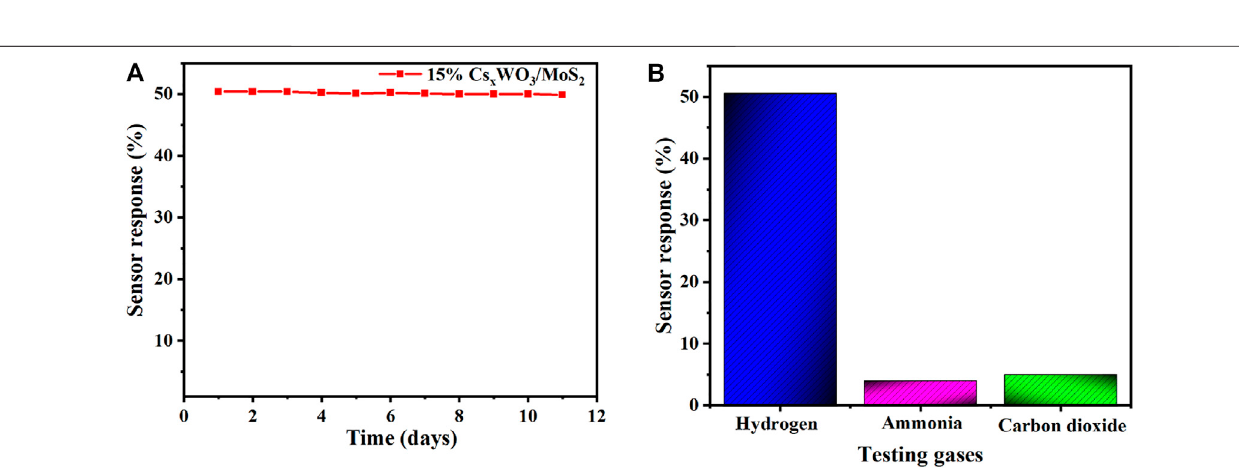
Frontiers in Materials |